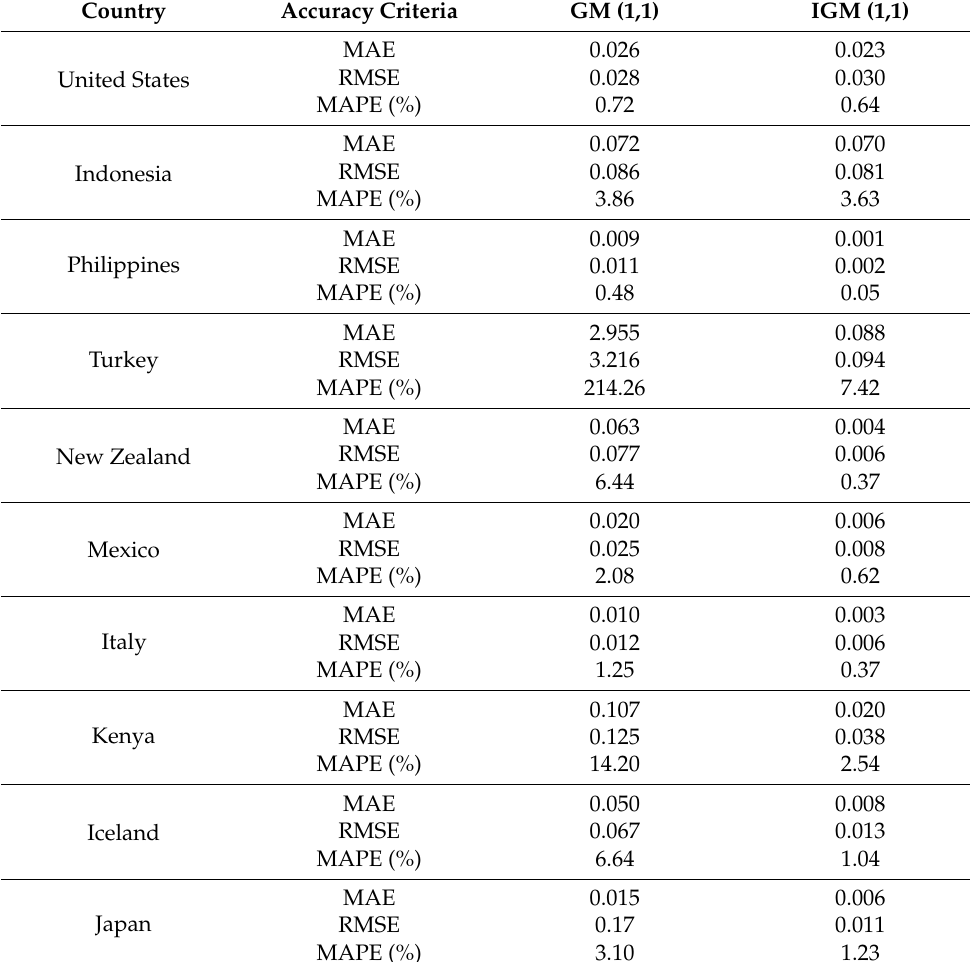
Table 3. The accuracy evaluation metrics for comparing the GM (1,1), and IGM (1,1) models. Country Accuracy Criteria United